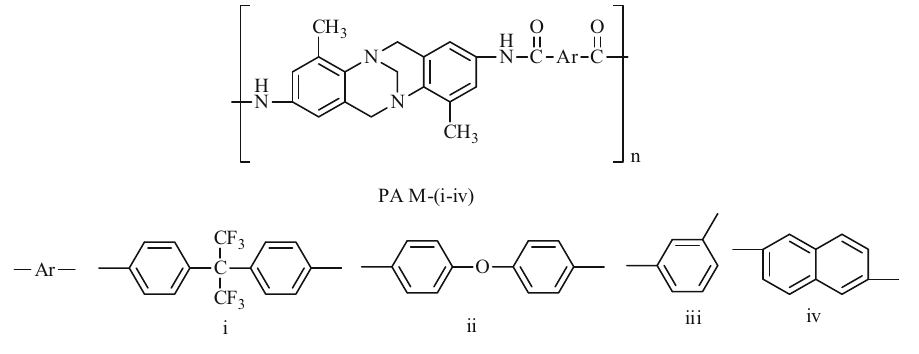
Figure 18: Structure of the PAs having TB unit ( 97 )